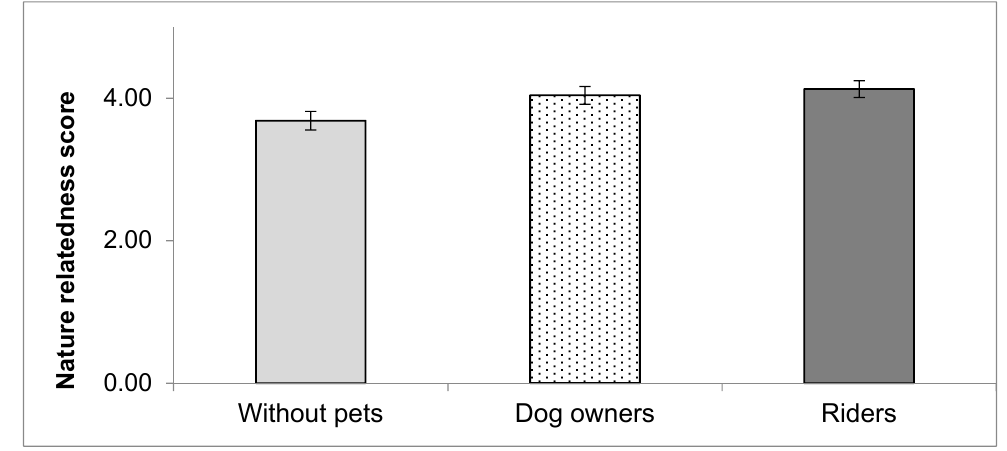
Figure 1. Mean and 95% confidence intervals of nature relatedness scores by study group .